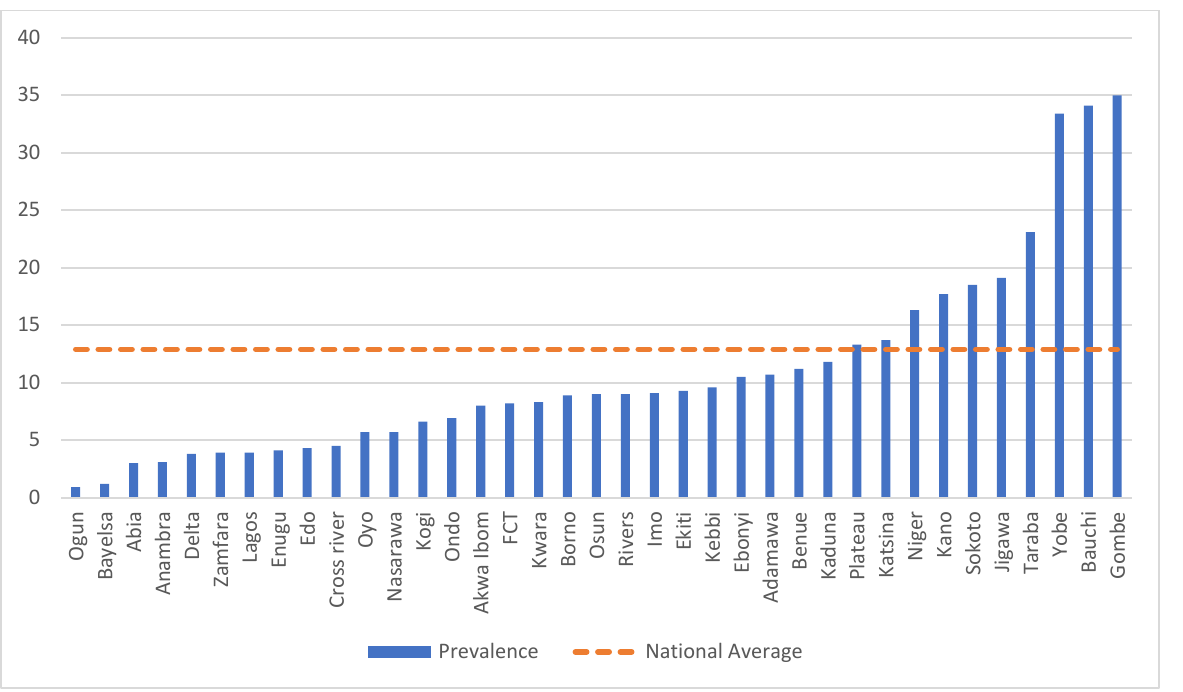
Figure 1. Period prevalence of diarrhea during the two weeks prior to the survey among children under 5 years of age by state compared to the national average of 12.9%. Table 2. Factors associated with childhood diarrhea during the two weeks prior to the survey in the 2018 Nigeria DHS (N =